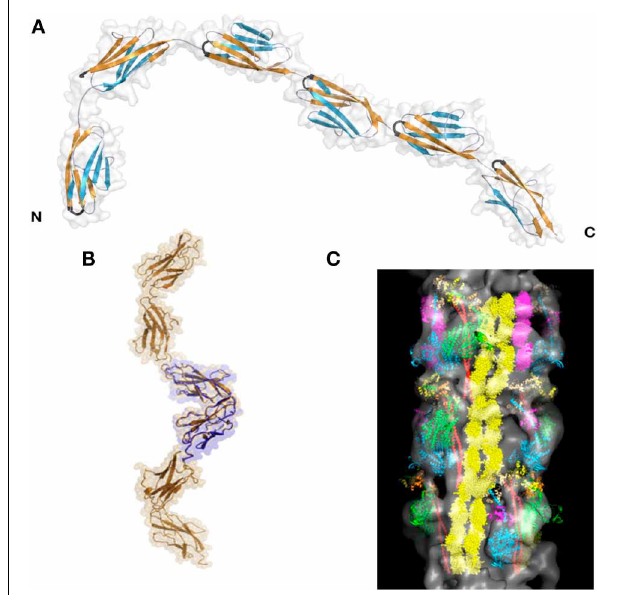
FIGURE 3 | Superstructure of titin. (A) I65-I70, as determined via SAXS and X-ray crystallography. This structure shows both a “stiff,” extended segment, along with a hinge point. Reproduced with permission from Von Castelmur et al. (2008). (B) A SAXS model of the 11-domain super-repeat of titinintheAband.Herethehelicaltwistofthetitinmoleculeisclearlyvisible. Reproduced with permission from Tskhovrebova et al. (2010). (C) Shows this same titin super-repeat, in yellow, mapped onto a full thick filament, as it may appear in vivo . Reproduced with permission from Al-Khayat et al.